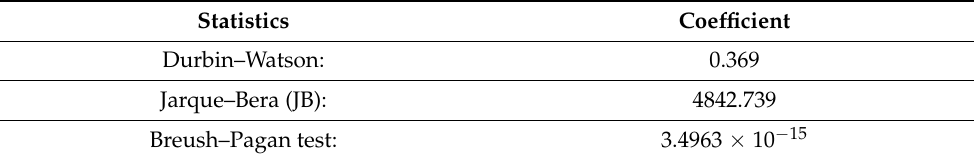
Table 6. Statistical